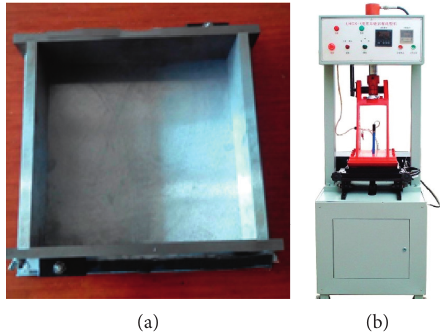
Figure 7: (a) Rutting plate mold and (b) rutting plate rolling machine.